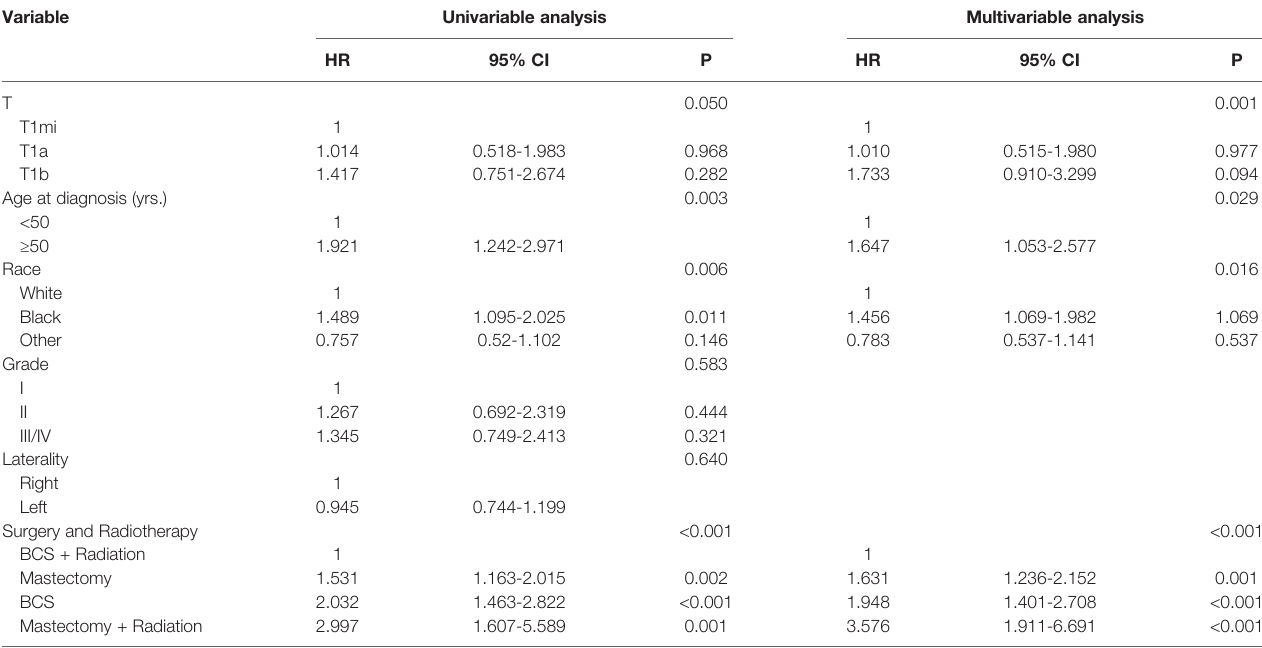
TABLE 2 | Univariable and multivariable Cox proportional hazard model analysis of overall survival in node-negative triple-negative breast cancer patients with tumor size less than 1 cm. Variable